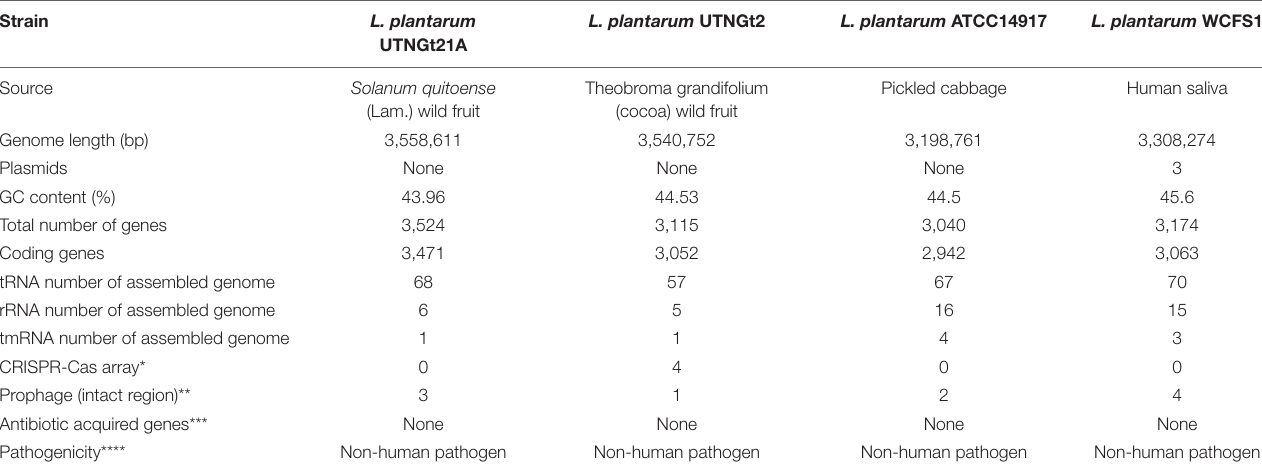
TABLE 1 | Genome features of L. plantarum UTNGt21A compared with the references L. plantarum WCFS1, L. plantarum ATCC14917, and L. plantarum UTNGt2 strains.